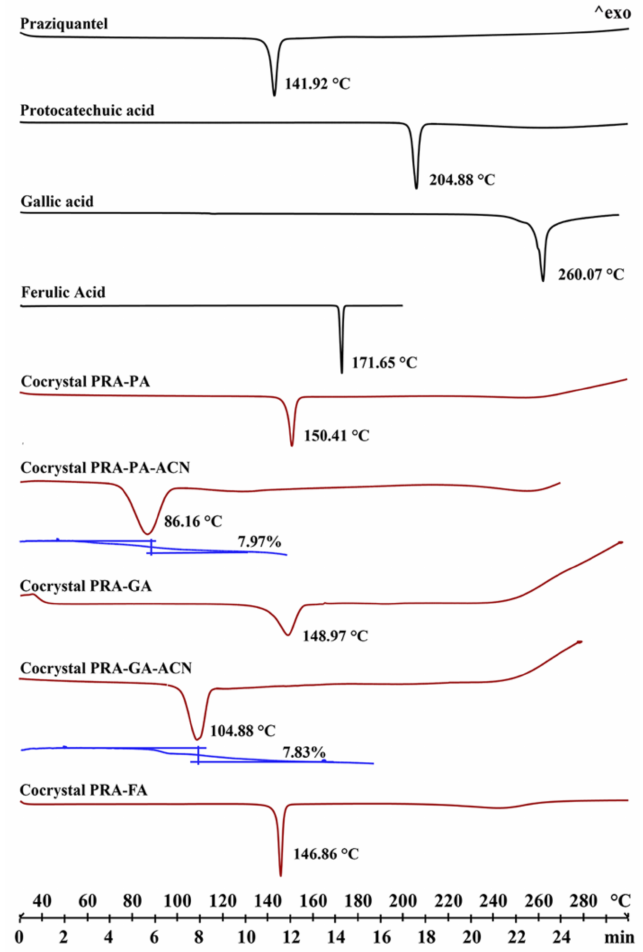
Figure 6. DSC profiles of the API, CCFs (in black), and the corresponding cocrystals (in red) and TG curves of solvates (in